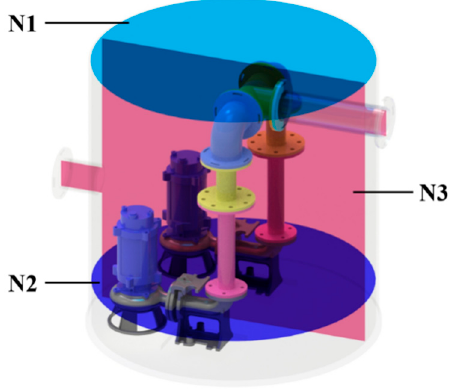
Figure 9. Schematic diagram of characteristic section.